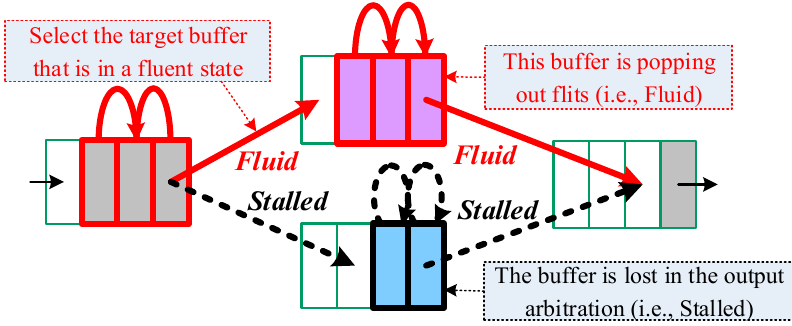
Figure 7. Path selection based on the buffer fluidity state.